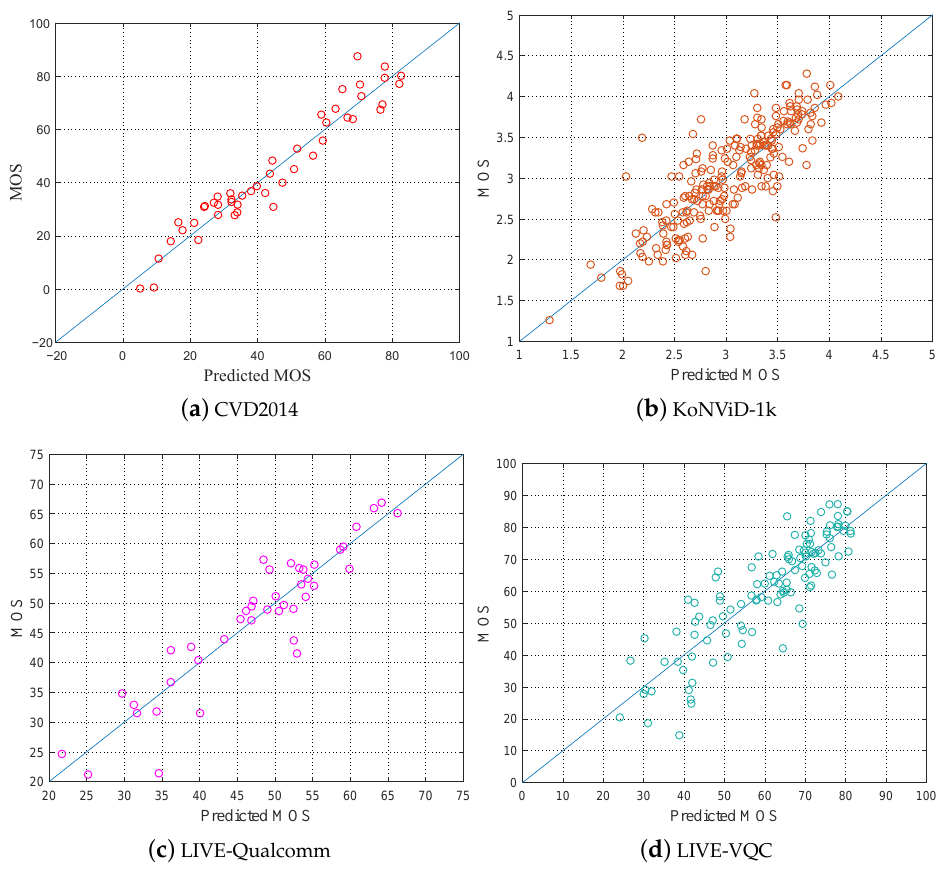
Figure 7. Scatter plots of the subjective scores provided by the dataset versus the objective scores provided by our method.